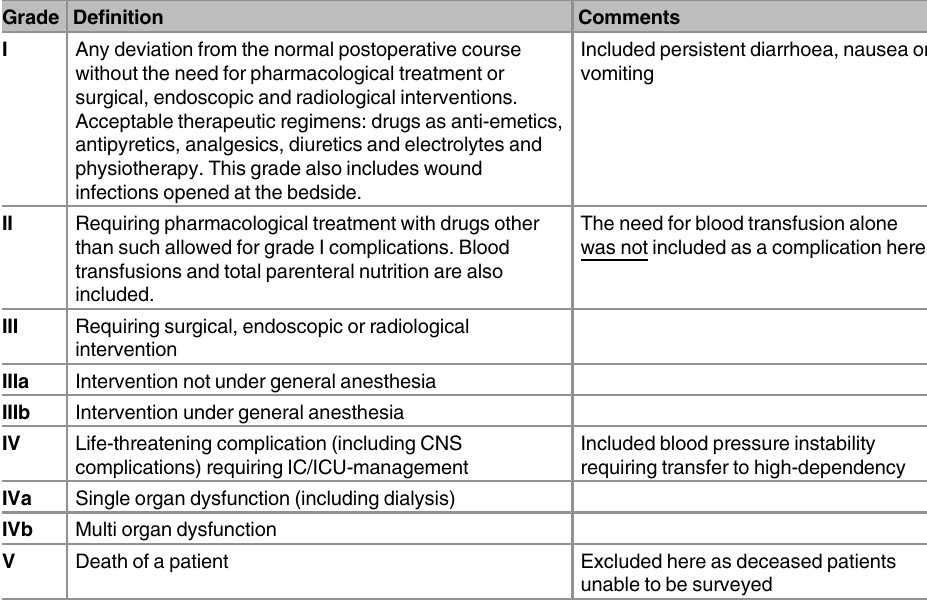
Table 1. Classification of